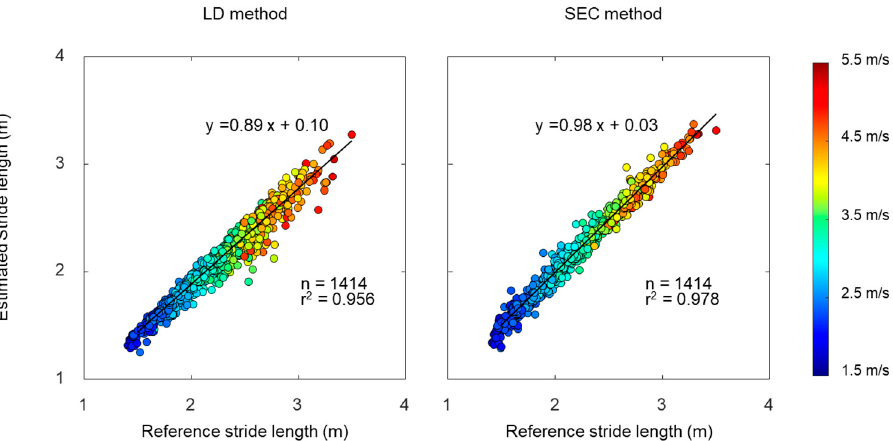
Figure 7. Relationships of stride lengths between estimated by linear dedrifting (LD) and spatial error correcting (SEC) methods and reference.